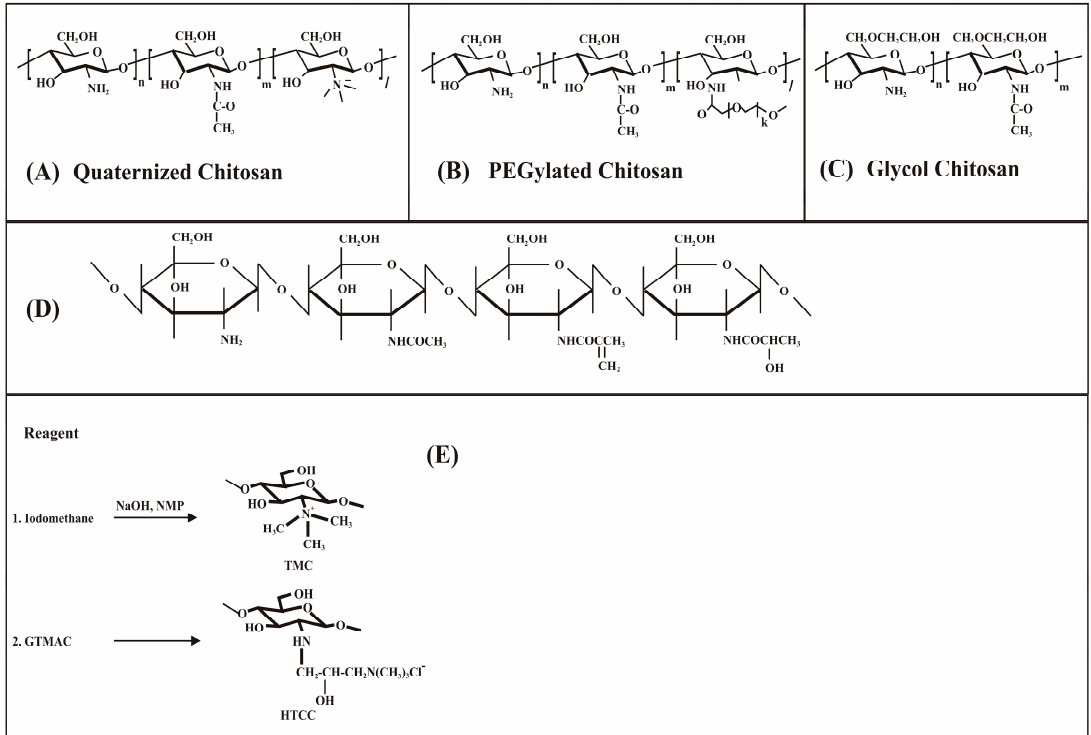
Figure 2. The comparison of chemical structural units: ( A ) chitin; and ( B ) chitosan formed following the process of deacetylation [16].